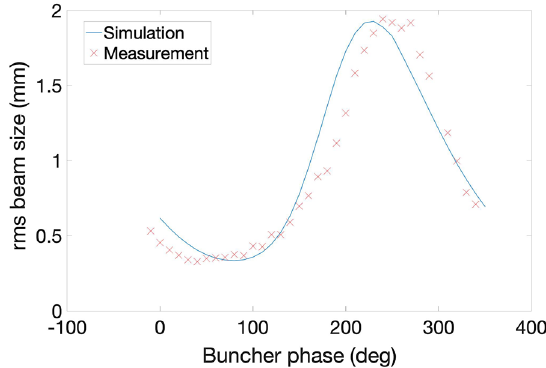
FIG. 8. Measured beam size versus buncher phase. For a buncher energy gain of 225 keV, the ASTRA simulations (blue curve) are a fair match to the data, which were taken with 40 pC bunches and 1-mm-diameter laser pulses with a 20 ps FWHM Gaussian temporal profile. FIG. 9. Electron beam current versus laser pulse